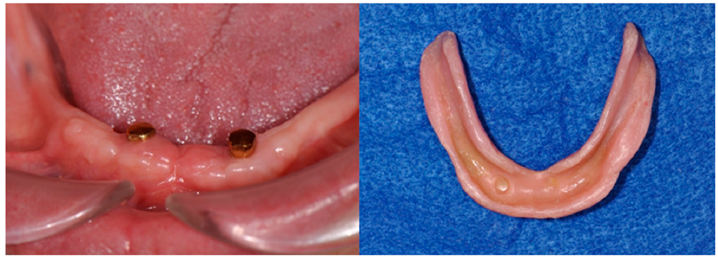
Figure 7. Three-month postoperative view of mandible ( Left ), and the tissue conditioning material was relined under denture base of the wearing denture ( Right ).